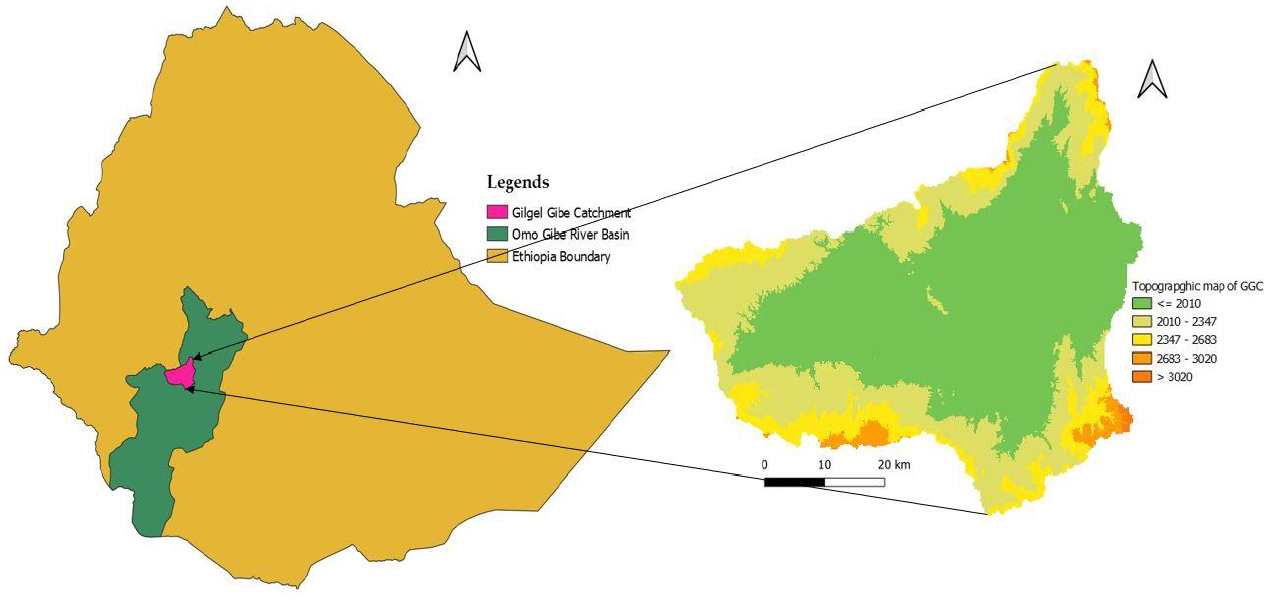
Figure 1. Location map of the study area.